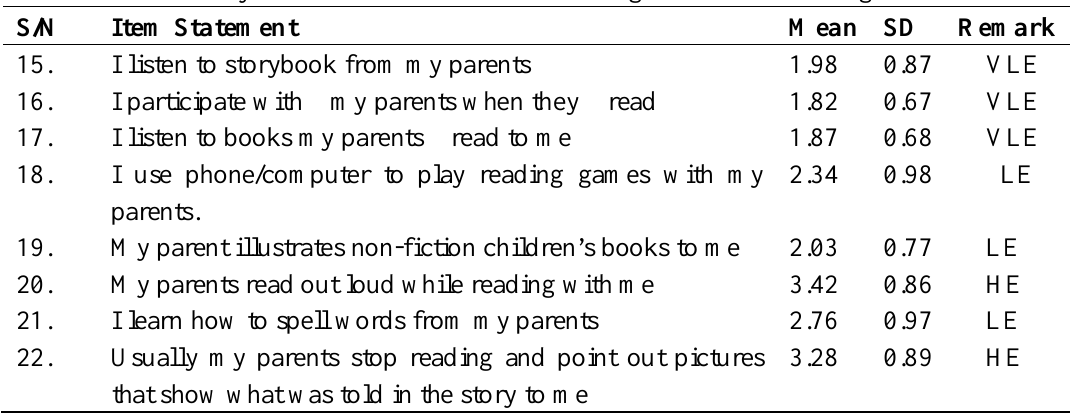
Table 3: Mean analysis